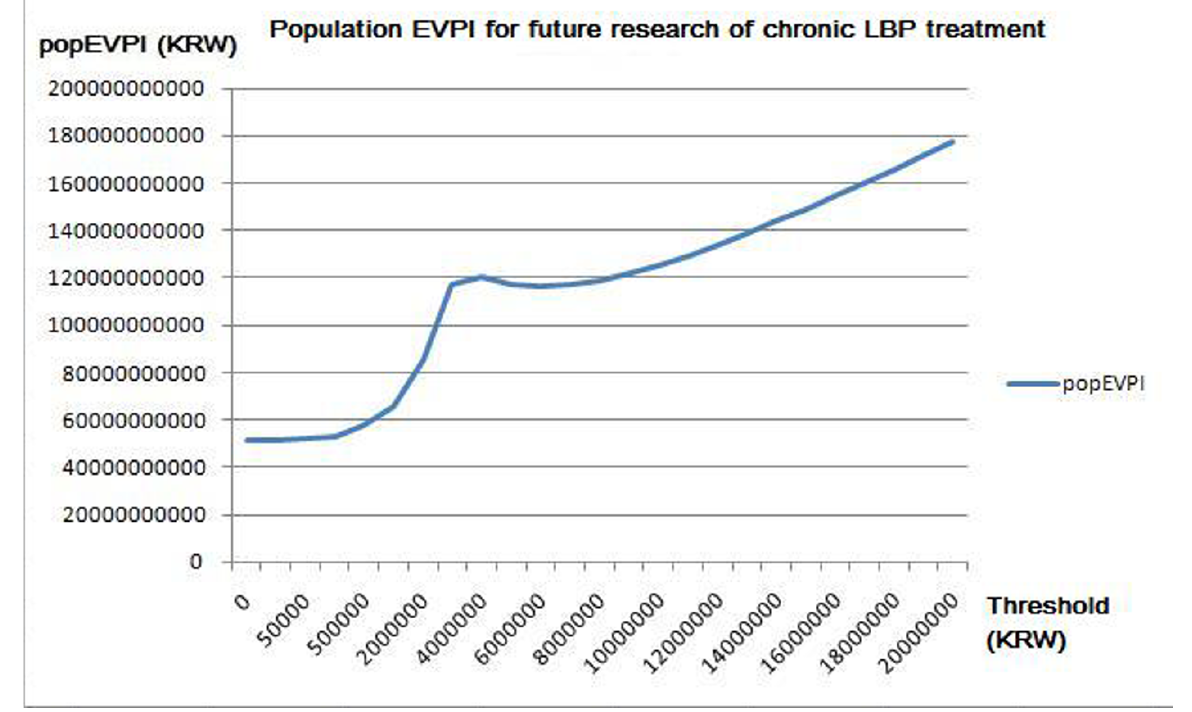
Figure 6 Population EVPI analysis result